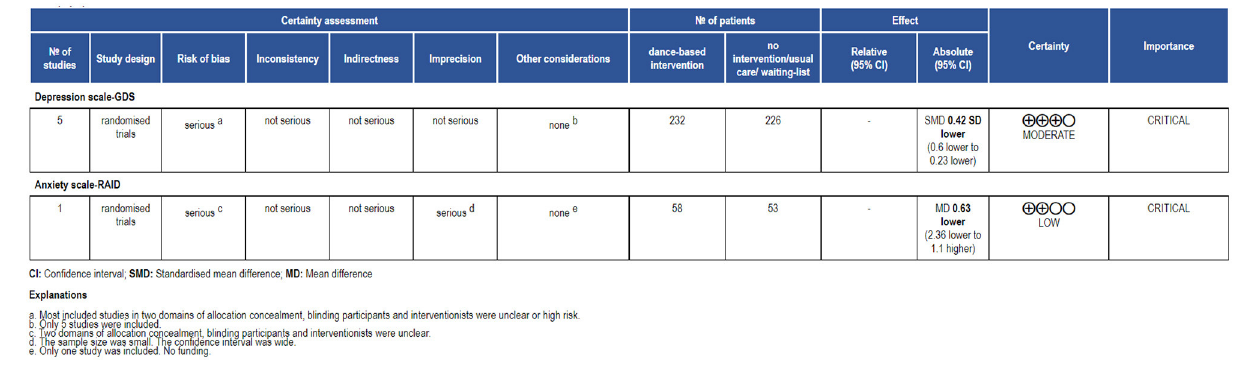
FIGURE 11 | GRADE evidence quality rating of depression and